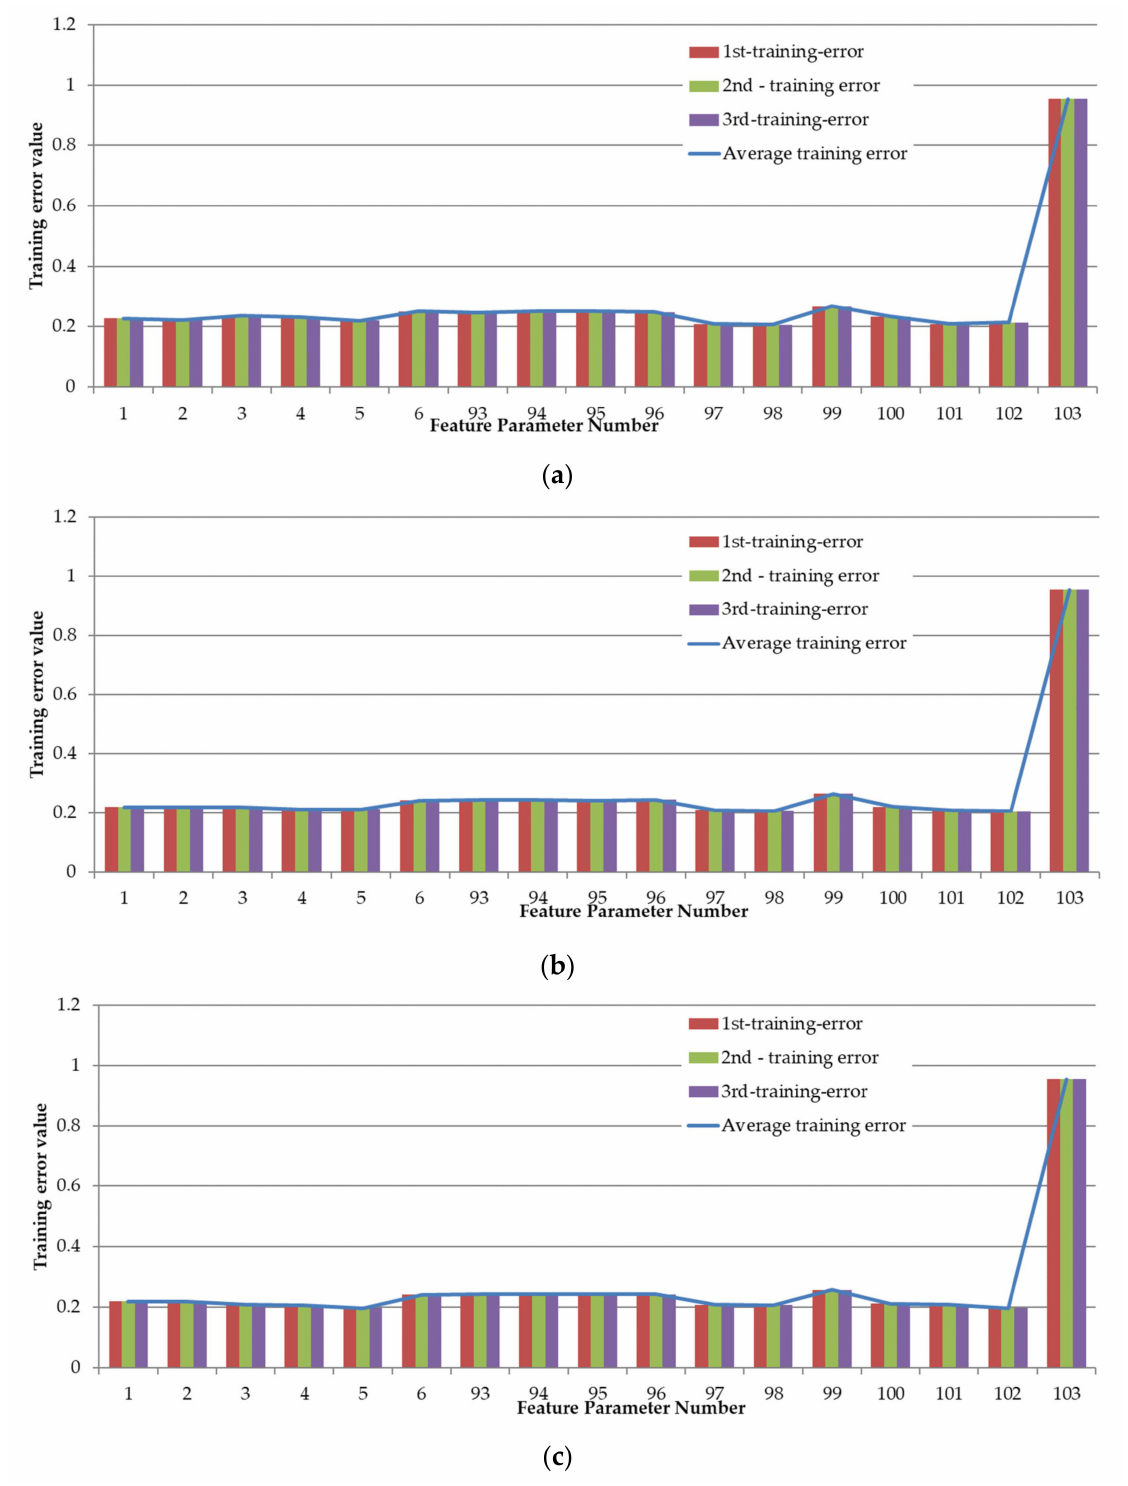
Figure 22. Training error for different MFs: ( a ) Test 1: numMF = 3; ( b ) Test 2: numMF = 6; ( c ) Test 3: numMF =